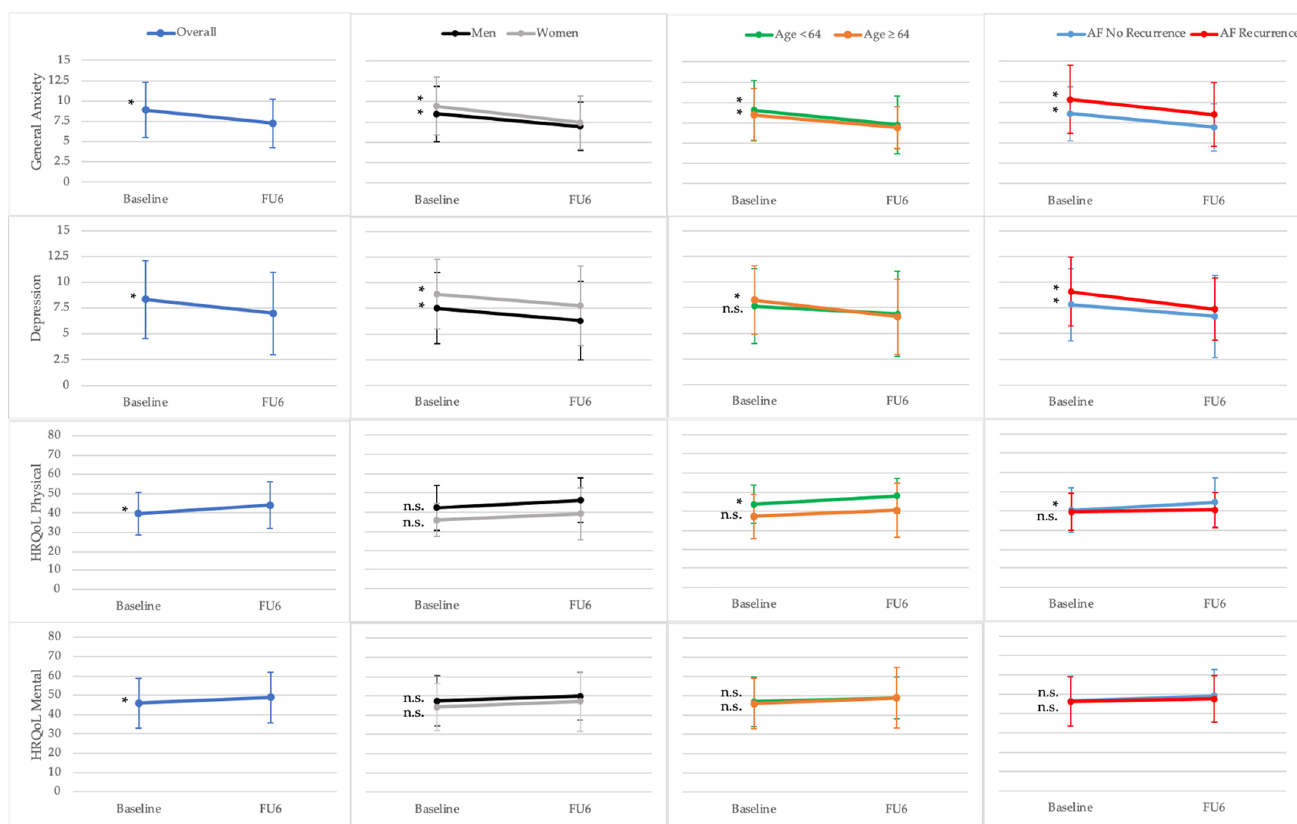
Figure 3. General anxiety, depression, and Health-related Quality of life (HRQoL) at baseline and 6 months follow-up (FU6). Results for paired t -tests and repeated measures ANOVA with the within- subject factor time (baseline, FU6) and the between-subject factor group (gender, age, documented atrial fibrillation (AF) recurrence). * p < 0.05 for paired t -test; n.s., not significant. Data points represent mean scores of the Hospital Anxiety and Depression Scale (General Anxiety and Depression) and of the 12-Item Short Form Health Survey. The error bars indicate the standard deviation.